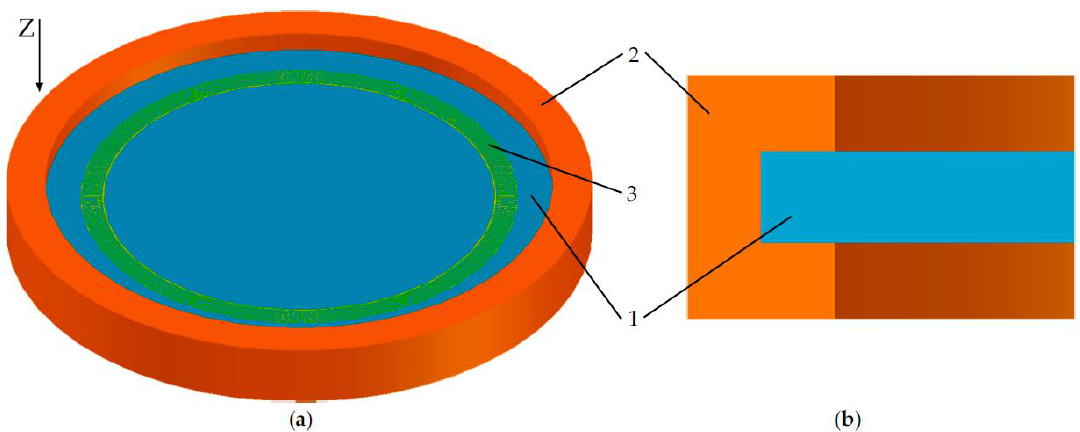
Figure 1. Membrane sensitive element. General view ( a ) and front view ( b ): 1: console; 2: housing; 3: inter-digital transducer.